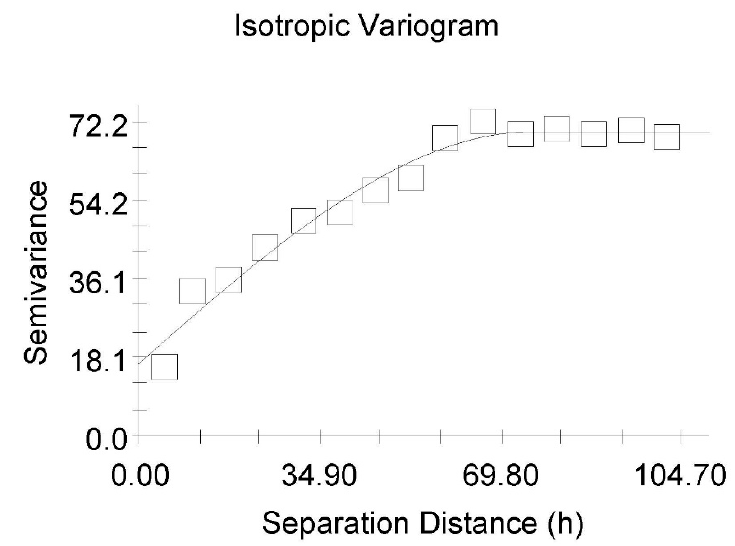
Figure 2. Semivariogram of VMC in the jointing stage with a spherical model.